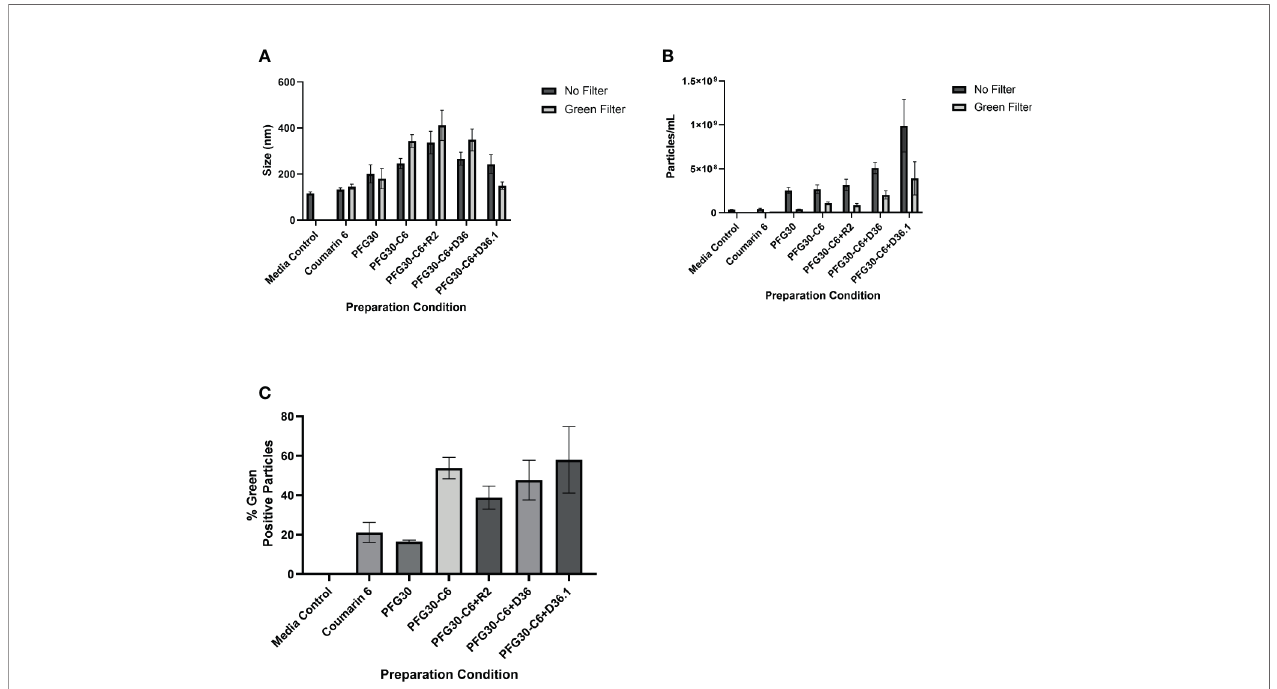
FIGURE 2 | NanoSight measurements of PFG30 encapsulated compounds. The size and number of particles produced after encapsulation in PFG30 were analyzed as follows: C6 alone (20 m M); PFG30 alone; PFG30 + C6 (20 m M); PFG30 + C6 + Retro-2 (50 m M R2); PFG30 + C6 + DHQZ 36 (50 m M); PFG30 + C6 + DHQZ 36.1 (50 m M). Encapsulation mixtures were prepared at 1:50 dilution for NanoSight analysis. (A) The size measurements of polymer aggregates with or without the use of a 500 nm green fi lter for fl uorescence. (B) The number of particles within the samples with or without the use of a 500 nm green fi lter for fl uorescence. (C) Particles observed in samples using a 500-nm green fi lter were compared with the total particles in the sample observed without the fi lter to generate a percentage estimation of C6 uptake within PFG30 aggregates. Data were obtained from at least two biological